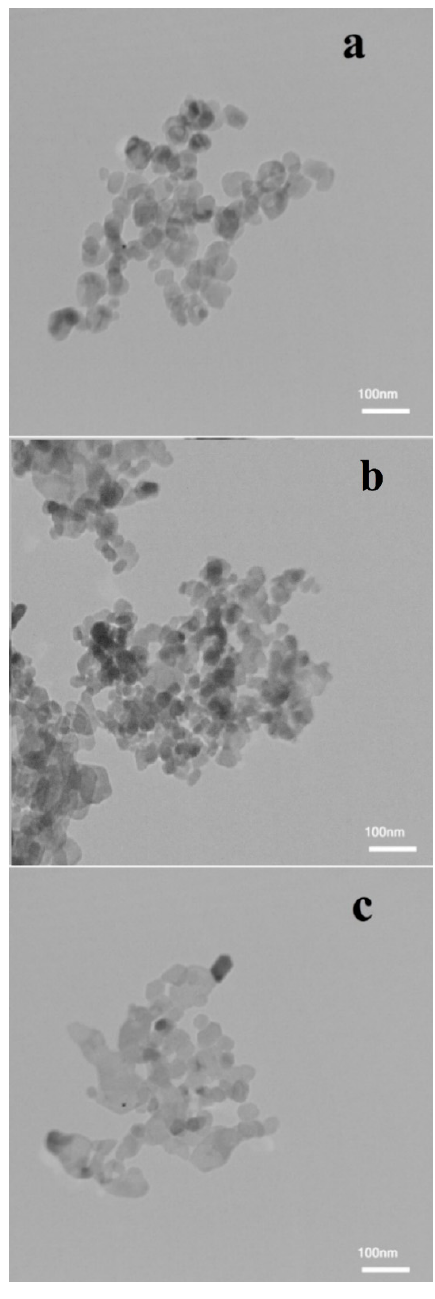
Figure 4. Transmission electron microcopy (TEM) images of ( a ) SiO 2 , ( b ) Al 2 O 3 and ( c ) Fe 2 O 3